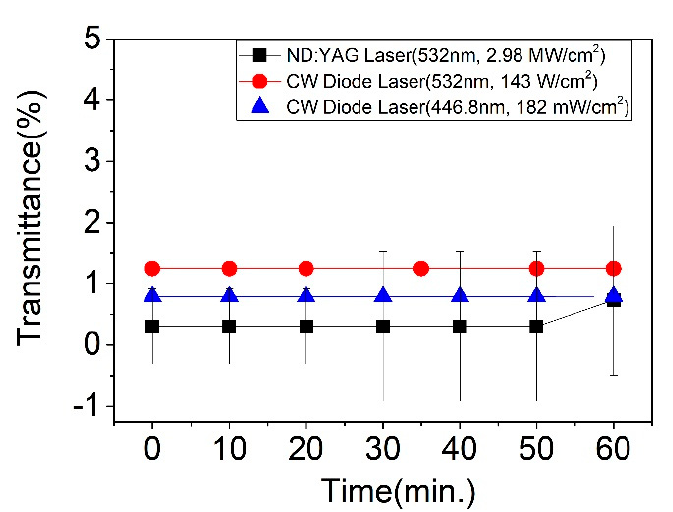
Figure 11. Stability and transmittance of filters via a high-pulse ND: YAG laser ( ∎ ) at 532 nm and a CW diode laser at 532 nm ( ● ) and a CW diode laser at 446.8 nm ( ▲ ) for one hour. As shown in Figures 5 and 10, when chiral concentration decreased continuously or moved to the thicker direction of the R-PCLC1 cell, the PBG position shifted toward the long wavelength and the bandwidth increased simultaneously. To study variations in the optical constants (i.e., refractive index, pitch, full width at half maximum (FWHM) of the band thickness) of PBGs, three different PBG experimental data with three other wave- length locations were selected and analyzed theoretically. Figure 12 shows three transmit- tance data of PBGs with center wavelength positions ( 𝜆 (cid:3003) ) 600 nm, 762 nm, and 964 nm of the R-PCLC1 cell. Solid lines are theoretical fitting data using Berreman’s 4 × 4 matrix method [23–25]. Theoretical fitting parameters, refractive index, and thicknesses for these three PBGs are given in Table 2. Additionally, the pitches were obtained by dividing the center wavelength of each PBG by the obtained average refractive index. Other fitting parameters are given for the BK7 substrate with a thickness of 1 mm and a refractive index of 1.5129. In the theoretical fitting, the polyimide (PI) layer was ignored. Due to the AR layer on BK7 in the CLC cell structure (Figure 2), the reflectance at each boundary surface of air/AR layer/BK7 layers was also ignored.